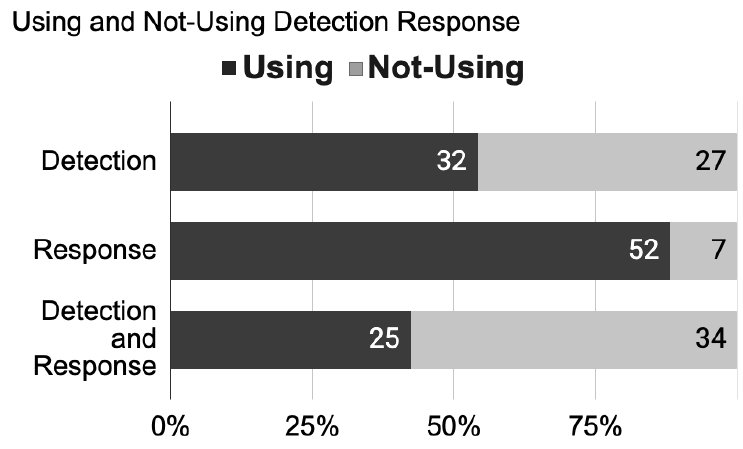
Figure 4. Percentage of articles using Detection, Response and both.